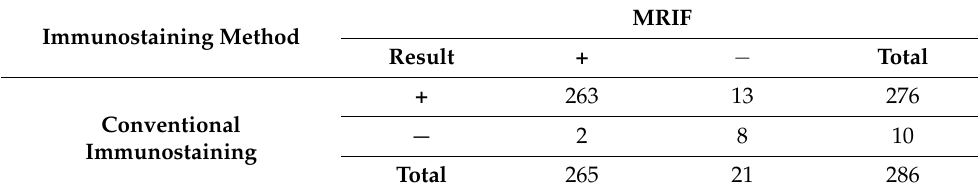
Table 2. Coincidence ratio between conventional IHC and MRIF